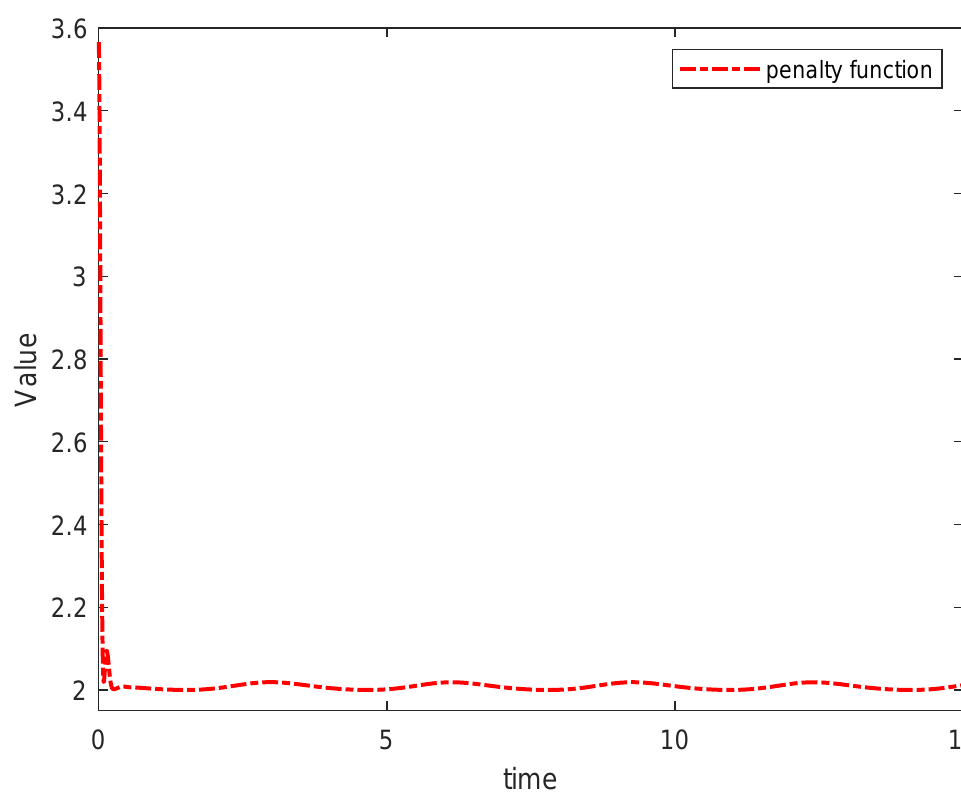
Figure 12. The value of penalty